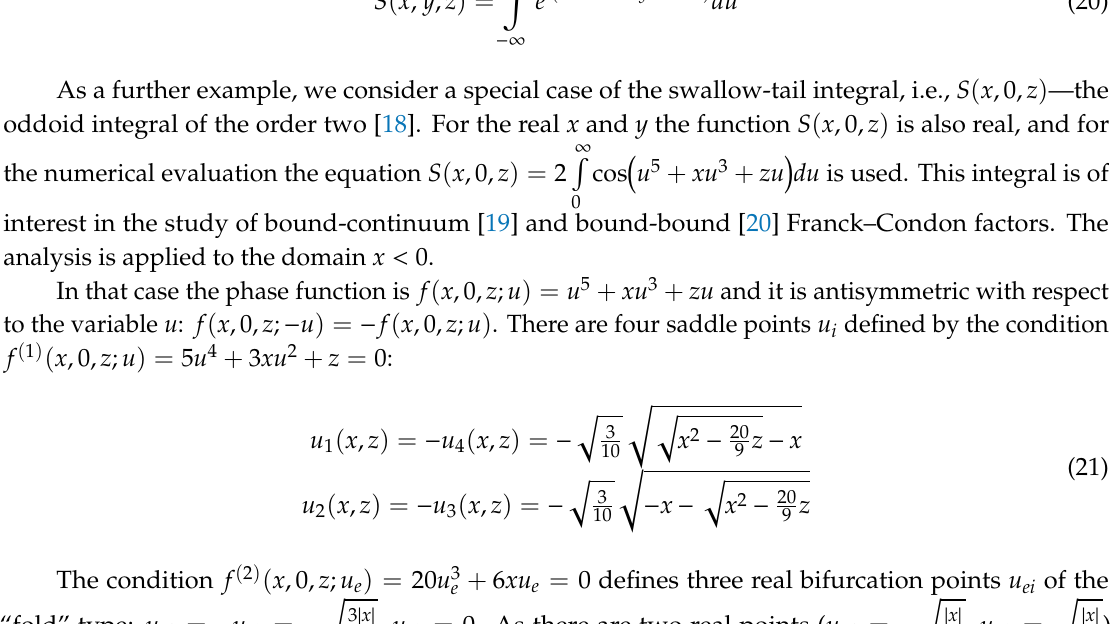
(cid:12) (cid:12) (cid:12) (cid:12) (cid:12) P ( x , y ) (cid:12) ( a ), function (cid:12) (cid:12) (cid:12) ( c ) for x ∈ [ − 10,0 ] and y ∈ [ 0,10 ]